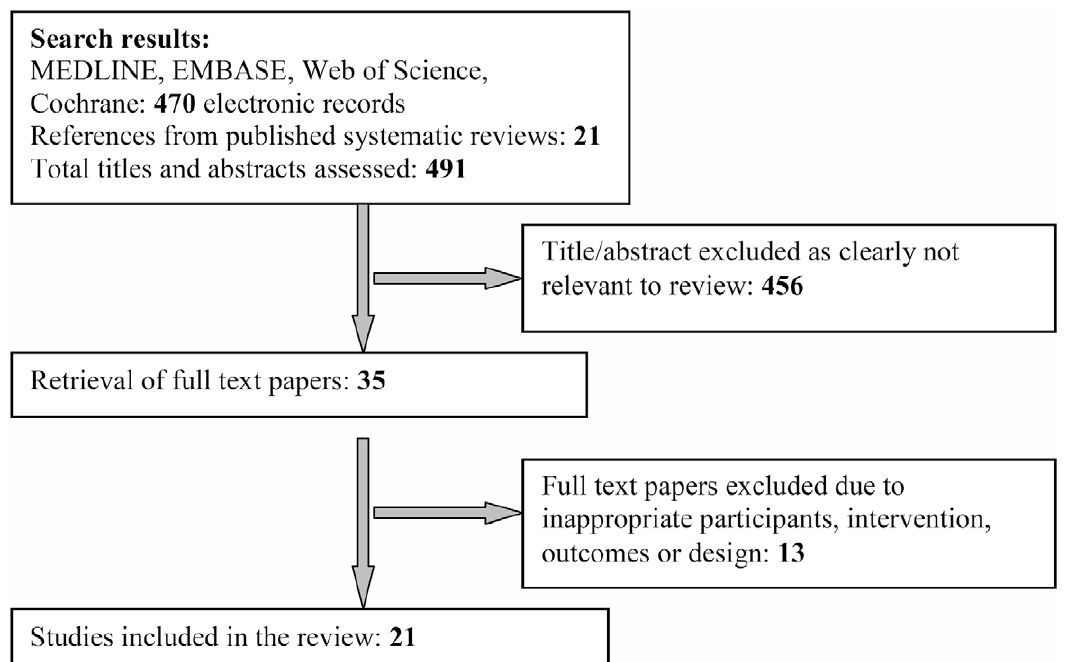
Figure 1. Study flow diagram of the search process and inclusion of studies into this review.